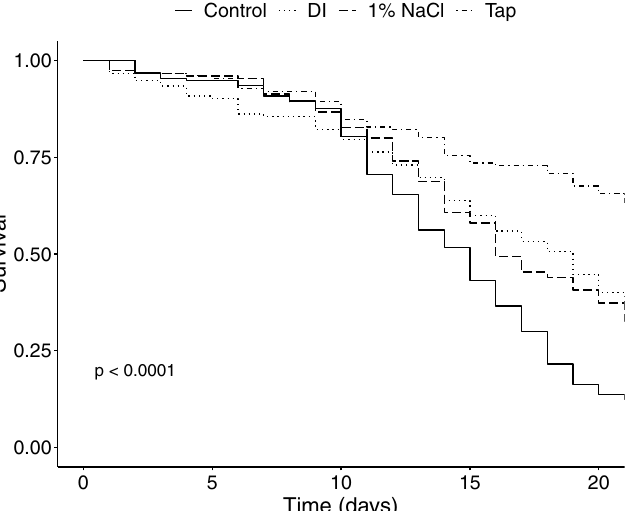
Figure 1. Kaplan–Meier survivorship curves showing Survival Probability between cages of bees offered 50% sugar syrup, pollen substitute, and either no water (Control), tap water (Tap), deionized (DI) water, and a 1% NaCl deionized water